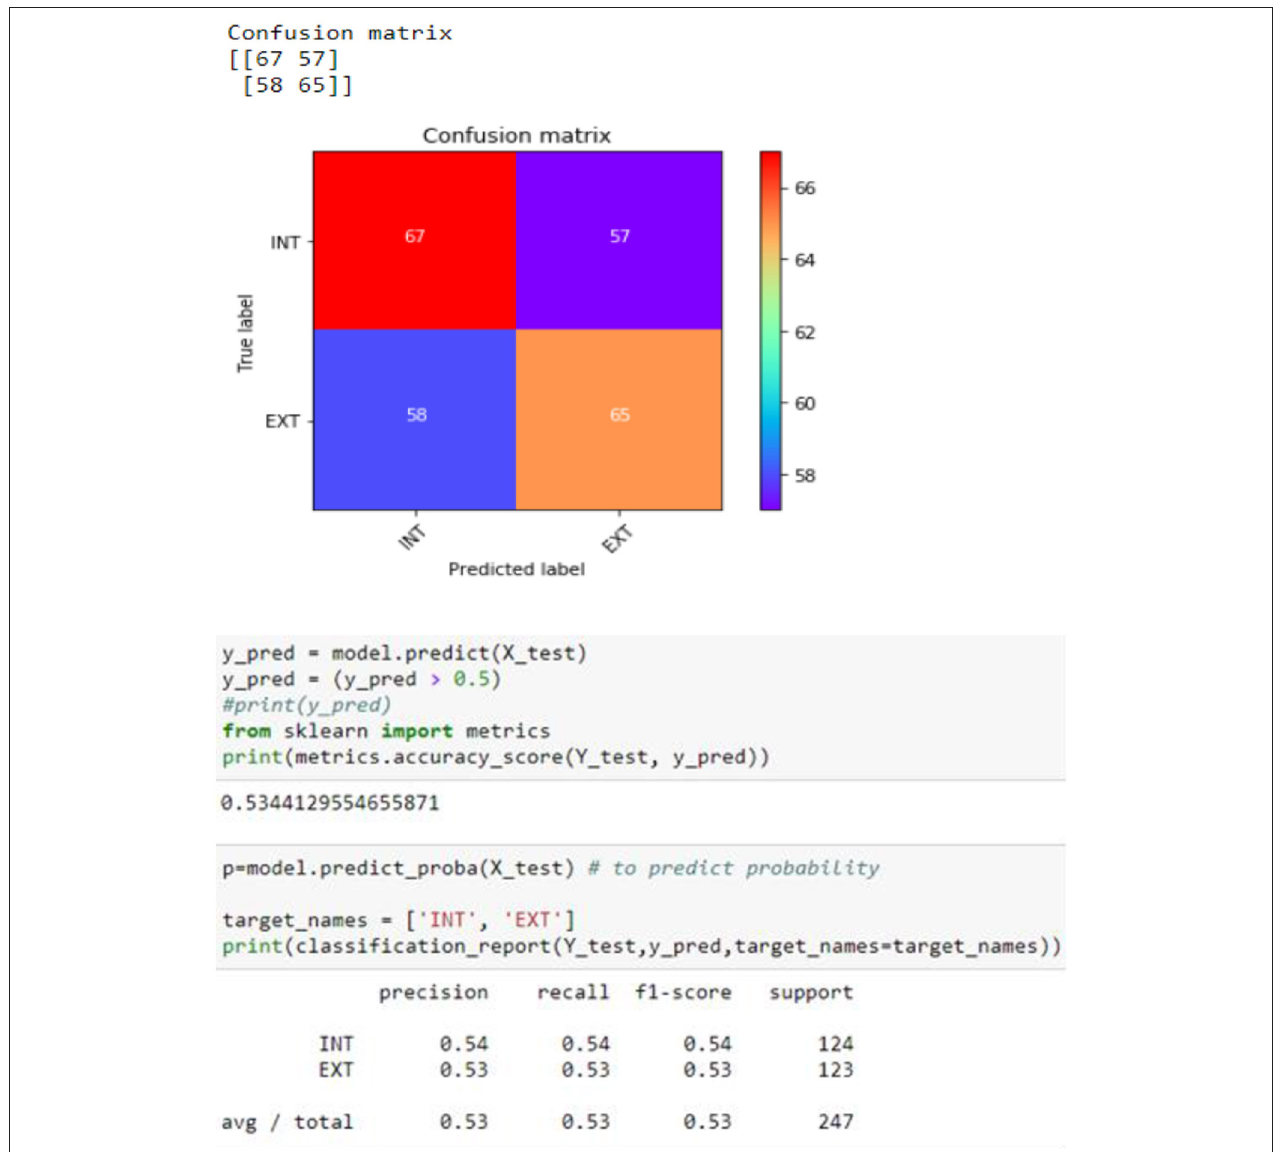
FIGURE 14 | Confusion